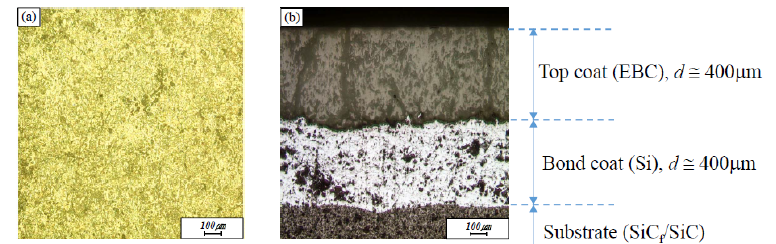
Figure 3. Optical micrographs of the ( a ) surface and ( b ) cross section of EBCs after 100 thermal shock cycles at 1350 °C.